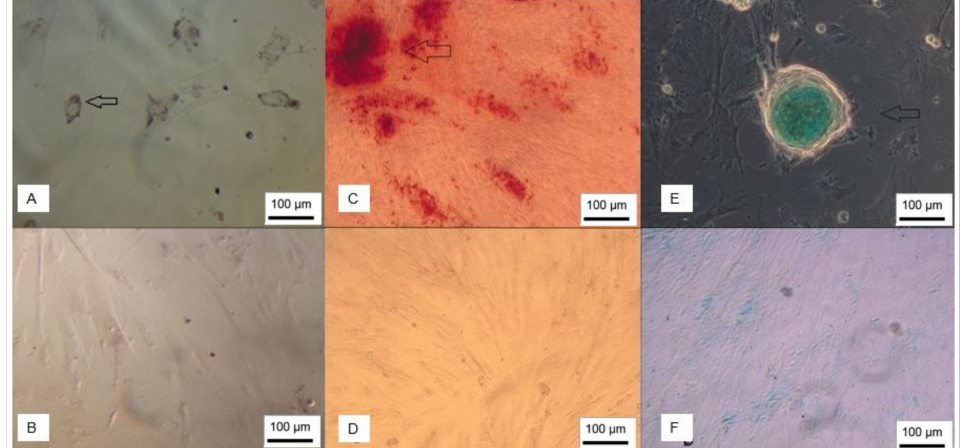
Figure 3. WJ-MSC trilineage differentiation. ( A ) Adipocytes stained with Oil Red O; ( B ) undiffer- entiated control; ( C ) cells showing mineralization stained with Alizarin Red; ( D ) negative control; ( E ) chondroblasts stained with Alcian Blue; ( F ) undifferentiated control (inverted optical microscopy, × 100). Scale bar, 100 µ m.